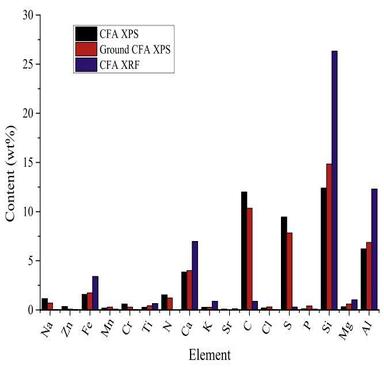
Comparisons between the element proportions extracted from XRF and XPS tests: (a) CFA samples; (b) SCBA samples. Fig. 5. High-resolution scan results for C1s and K2p for the SCBA and CFA.